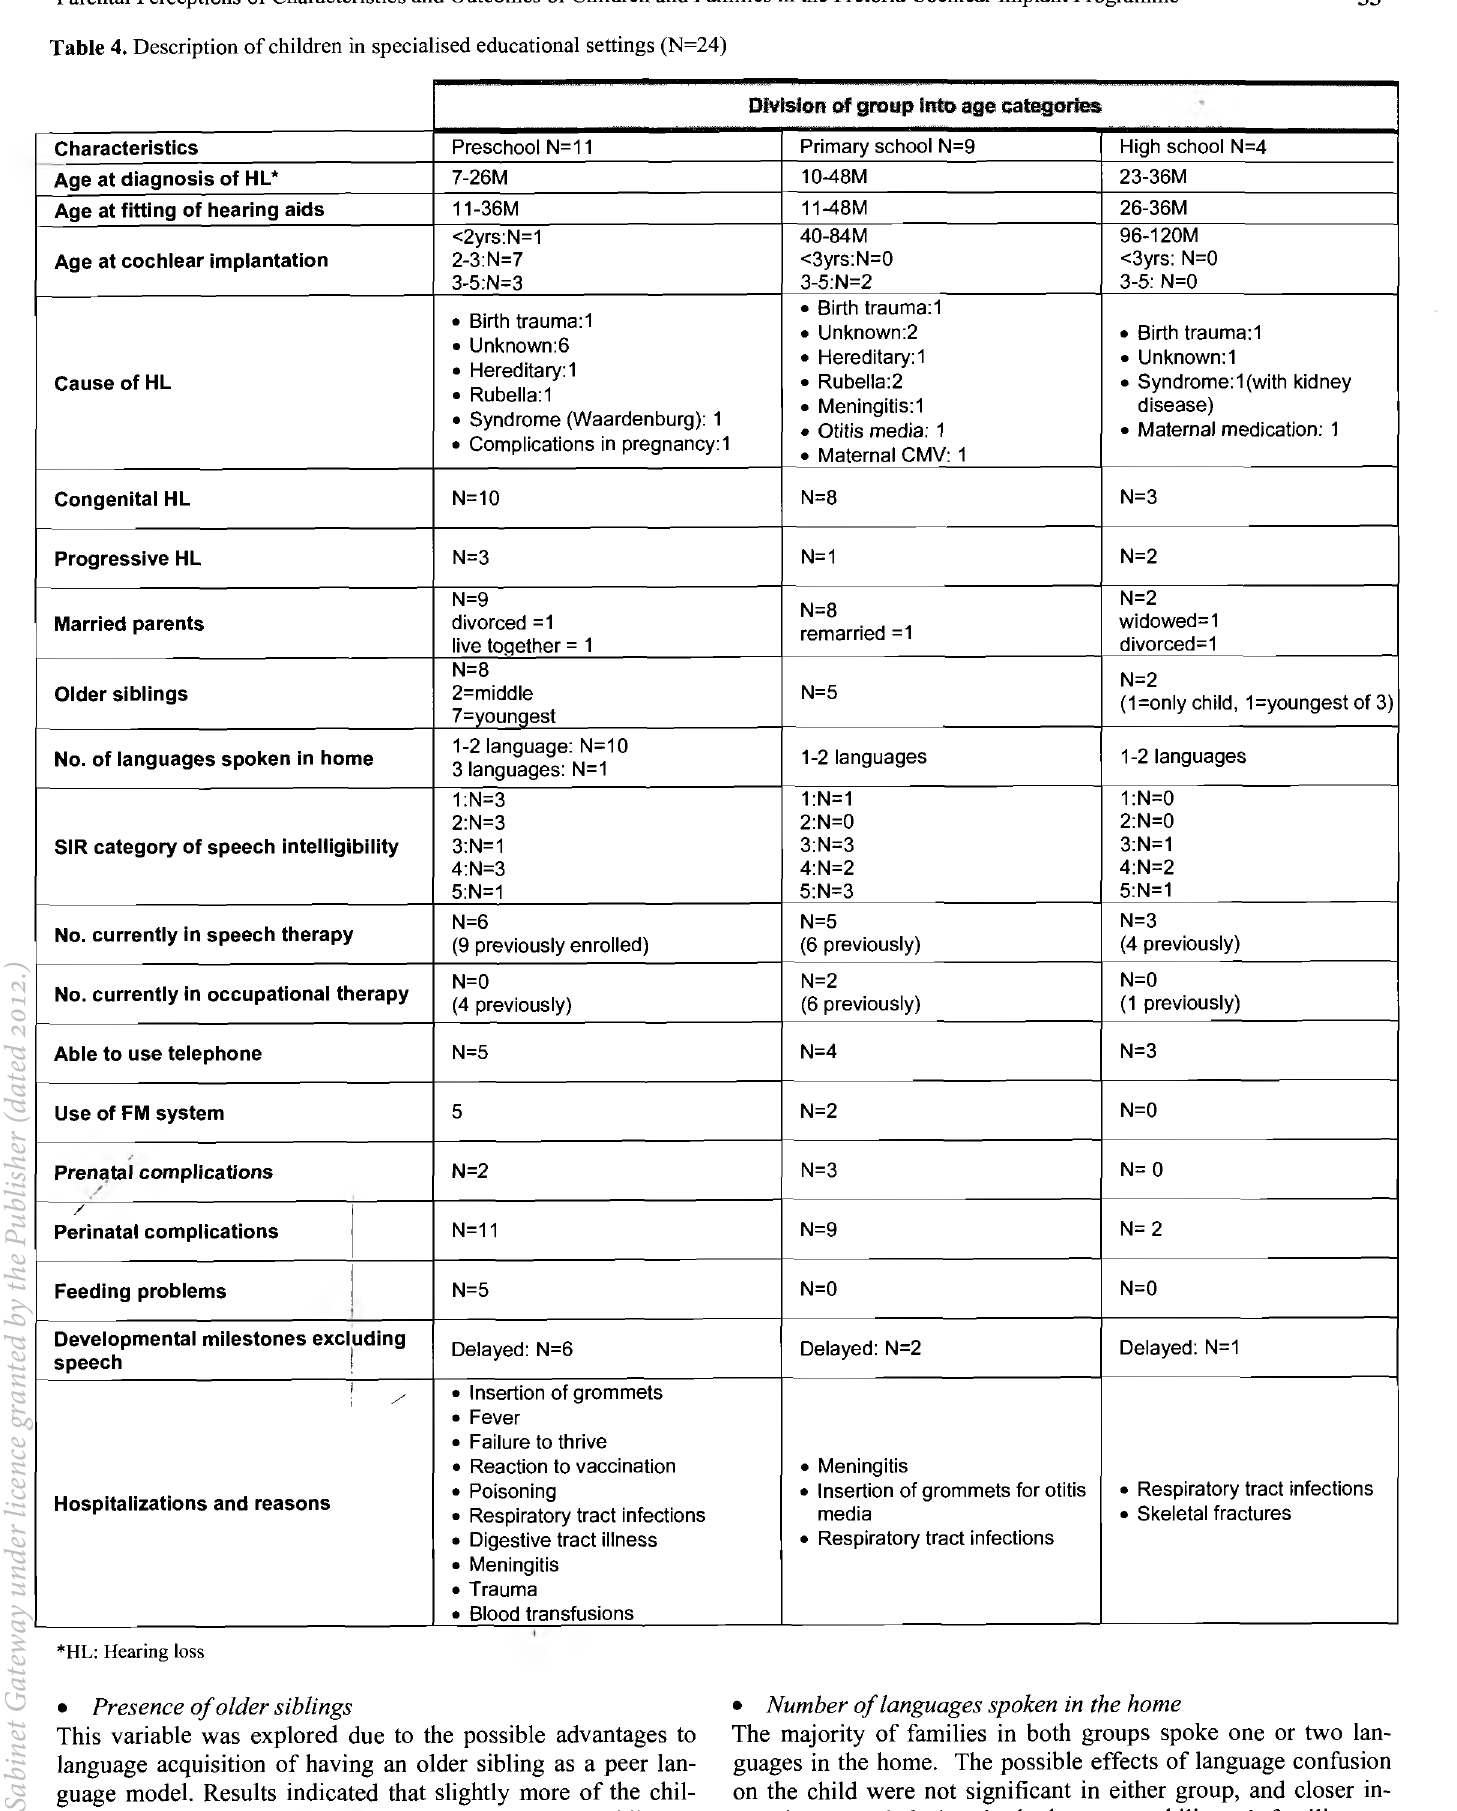
Division of group into age categories